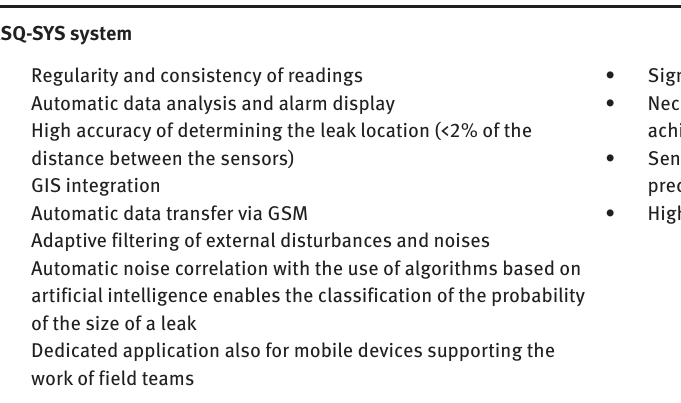
Table 1: Strengths and weaknesses of the systems.